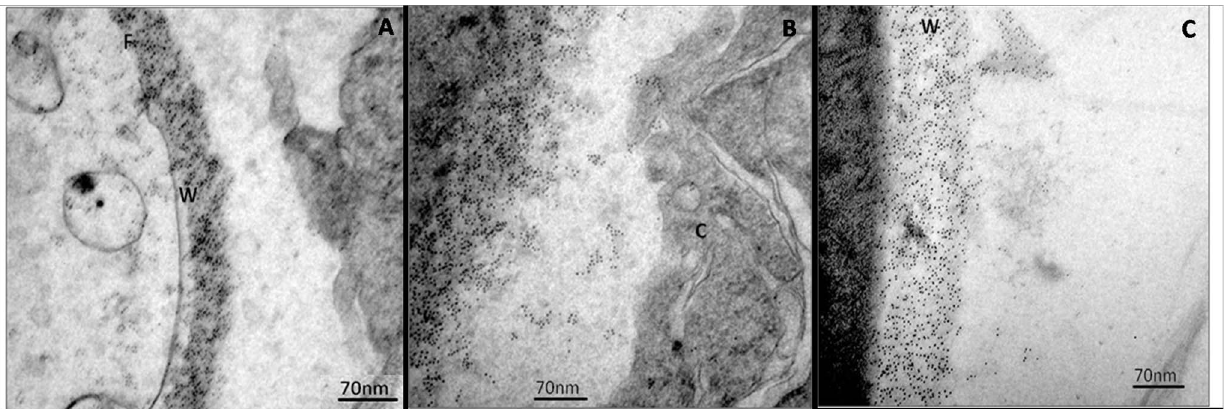
Figure 5. IEM detection of the 14-3-3 protein of P.brasiliensis during interaction with epithelial cells (A549) for 2 h (A), 5 h (B) and 8 h (C). Magnification 50,000 6 . F: fungus, W: fungal cell wall, V: vacuole, C: epithelial cell.